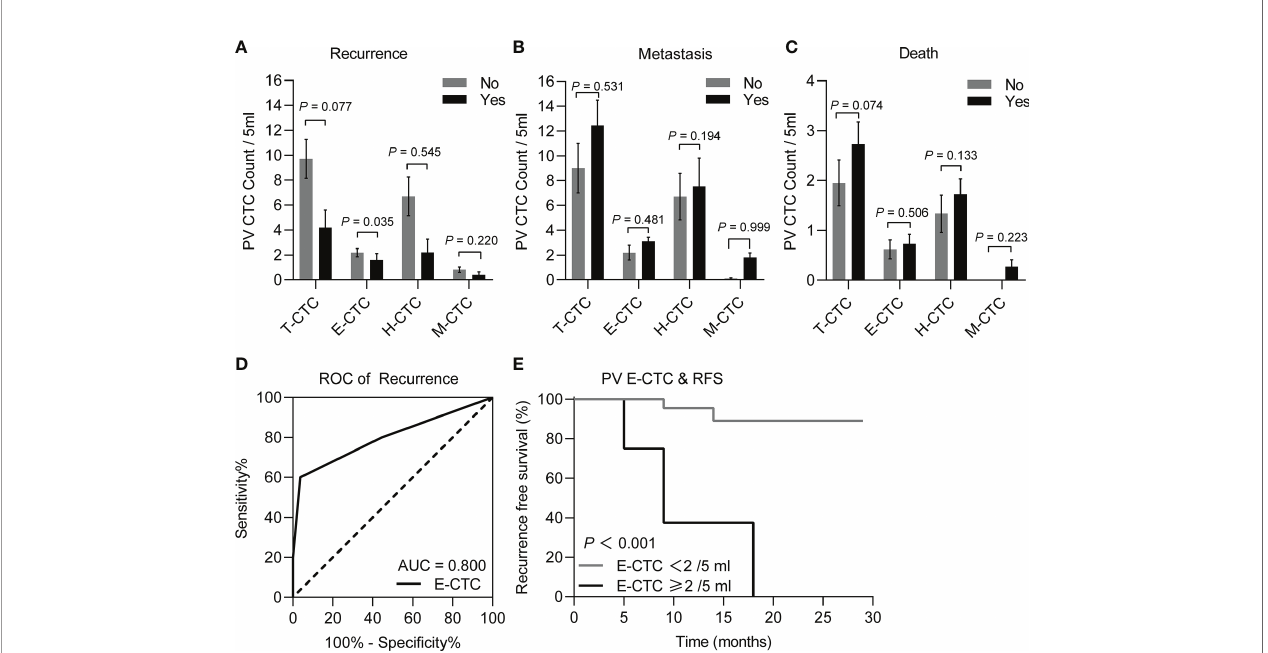
FIGURE 3 | Comparison of different CTC phenotype counts of peripheral blood samples between the PDAC patients (n=32) with different postoperative prognosis, including recurrence or recurrence-free (A) , metastasis or metastasis-free (B) , and death or survival (C) , through the Mann – Whitney U test, the results demonstrated that the recurrence patients (n=5) had signi fi cantly higher E-CTC counts than the recurrence-free patients (n=27) ( P < 0.05). (D) ROC curves for PV E-CTC (cut-off = 2 CTCs/5 ml, AUC = 0.800 95% CI 0.621 – 0.920; P = 0.032) regarding on recurrence. (E) Kaplan-Meier RFS strati fi ed with respect to the E-CTC cut-off value of 2/5 ml for PDAC patients, the curve showed patients with PV E-CTC ≥ 2/5ml had a signi fi cantly shorter RFS than patients with PV E-CTC < 2/5ml ( P =